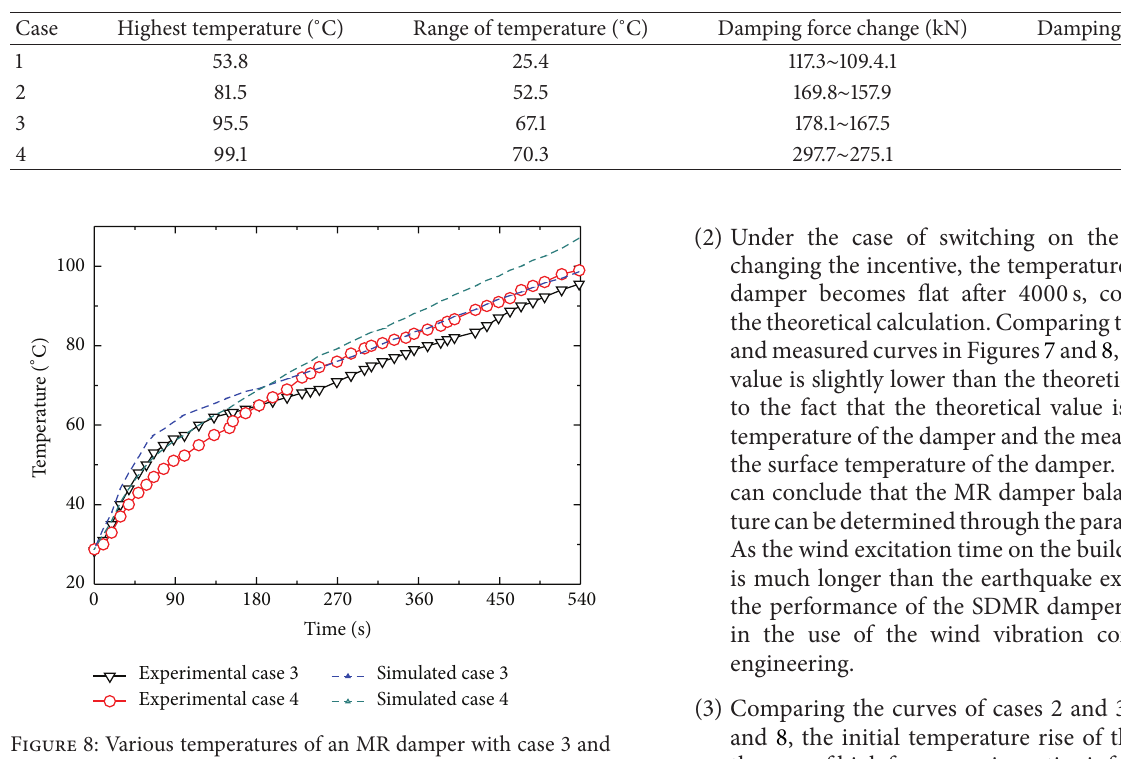
Figure 8: Various temperatures of an MR damper with case 3 and case 4.